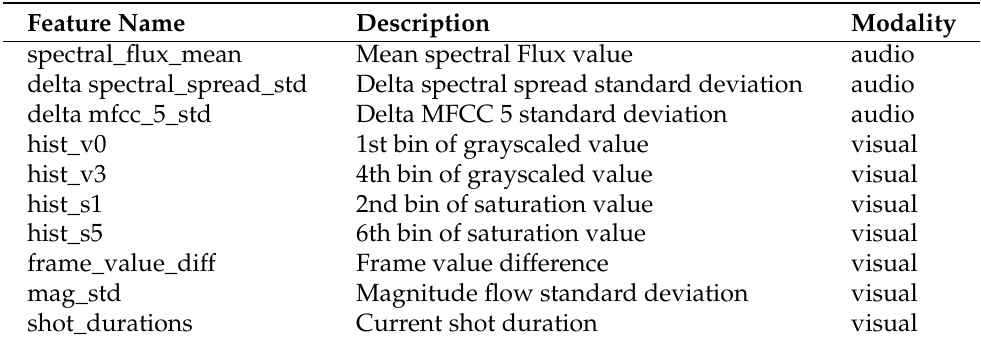
Table 6. The ten most valuable features of